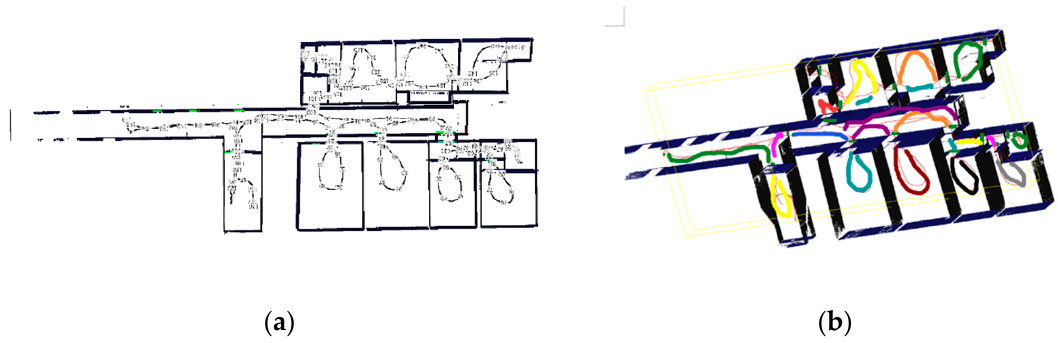
Figure 5. Position of doors subdivide trajectory segments. ( a ) Sample trajectory points. ( b ) Partition of trajectory segments.